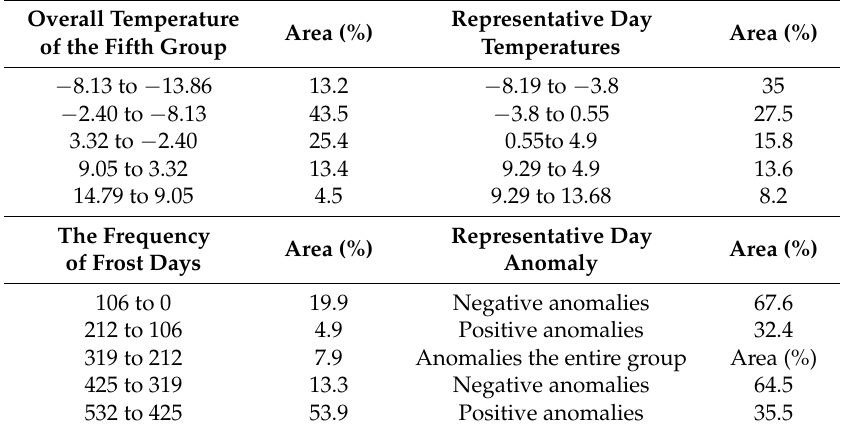
Table 6. Percentage of the covered area of different classes of average temperature, anomalies and frequency of frosts for the fifth